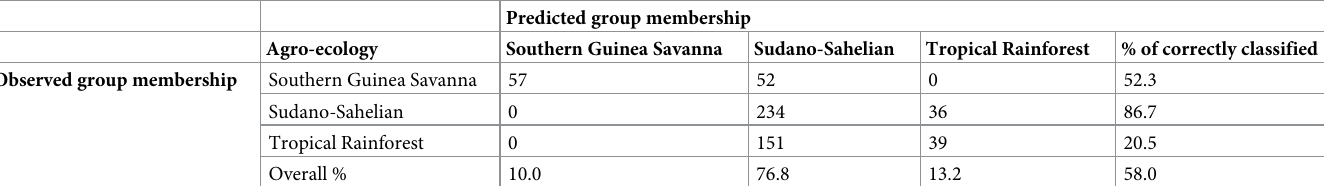
Table 9. The classification matrix of birds in the three agro-ecological zones based on CHAID model.